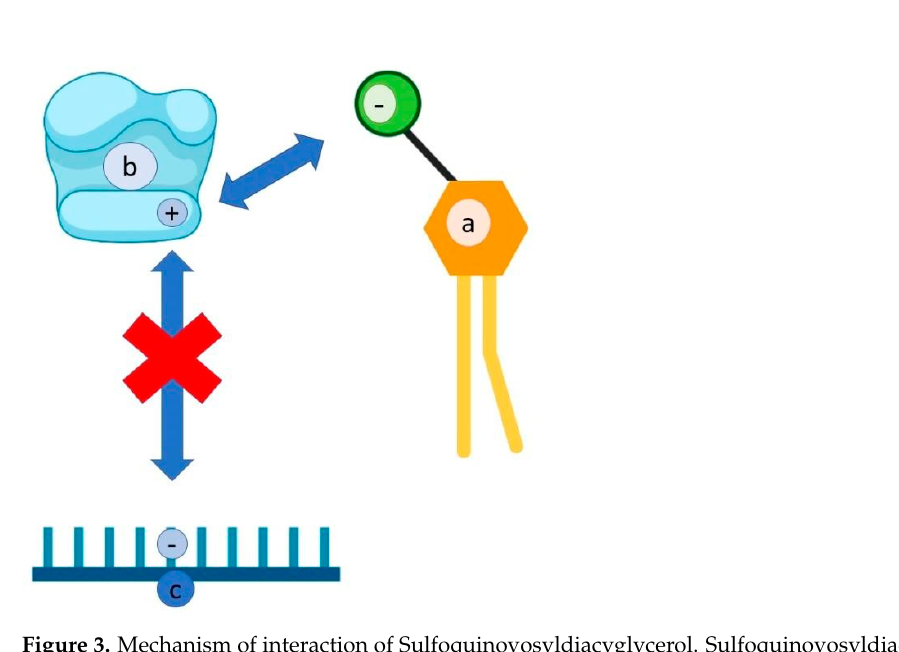
Figure 3. Mechanism of interaction of Sulfoquinovosyldiacyglycerol. Sulfoquinovosyldiacyglycerol, thanks to negative charge ( a ), interacts with the positive charge of DNA polymerase ( b ), thus inhibiting the negative charge of the phosphodiester bonds of DNA ( c ).